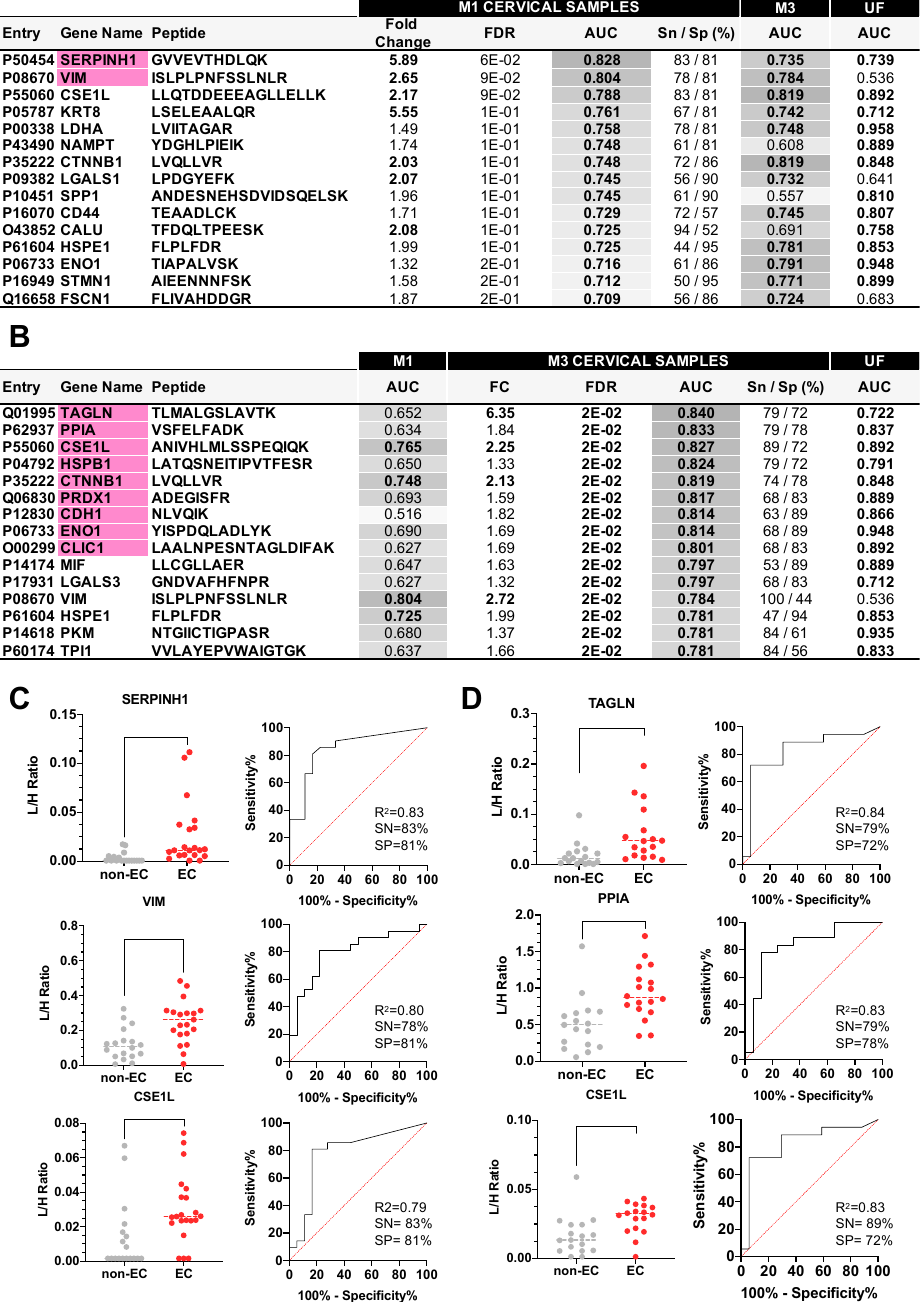
Figure 5. Proteins showing significantly different levels in M1 and M3 cervical fluids from 39 patients. ( A ): Statistical results of the 15 proteins presenting an AUC > 0.7 in the M1 cervical fluids from the verification study when comparing EC (n = 21) vs. non-EC (n = 18) women. Proteins with AUC values higher than 0.8 are highlighted in pink. AUC values for the same proteins measured in the M3 cervical fluids and the raw uterine fluids are also shown. These values are graded in grey according to their discriminative power. ( B ): Top 15 proteins presenting an FDR < 0.05, Fold Change > |1.3| and AUC > 0.7 in the M3 cervical fluid of 37 patients when comparing EC (n = 18) vs. non-EC women (n = 19). Proteins with AUC values higher than 0.8 are highlighted in pink. AUC values for the same proteins measured in the M1 cervical fluids and the raw uterine fluids are also shown. These values are graded in grey according to their discriminative power. ( C ): Dot plots of the top three performing proteins representing the light/heavy ratios (L/H) obtained by LC-MS/MS PRM when analyzed in M1 cervical fluids, and their corresponding ROC curve. ( D ): Dot plots of the top